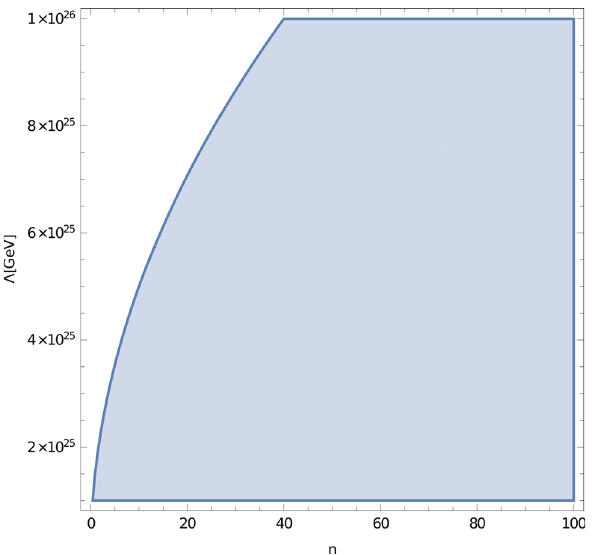
Fig. 3 Excluded parameter space ((cid:14), n ) from DAMA experiment, fix- ing m = 2